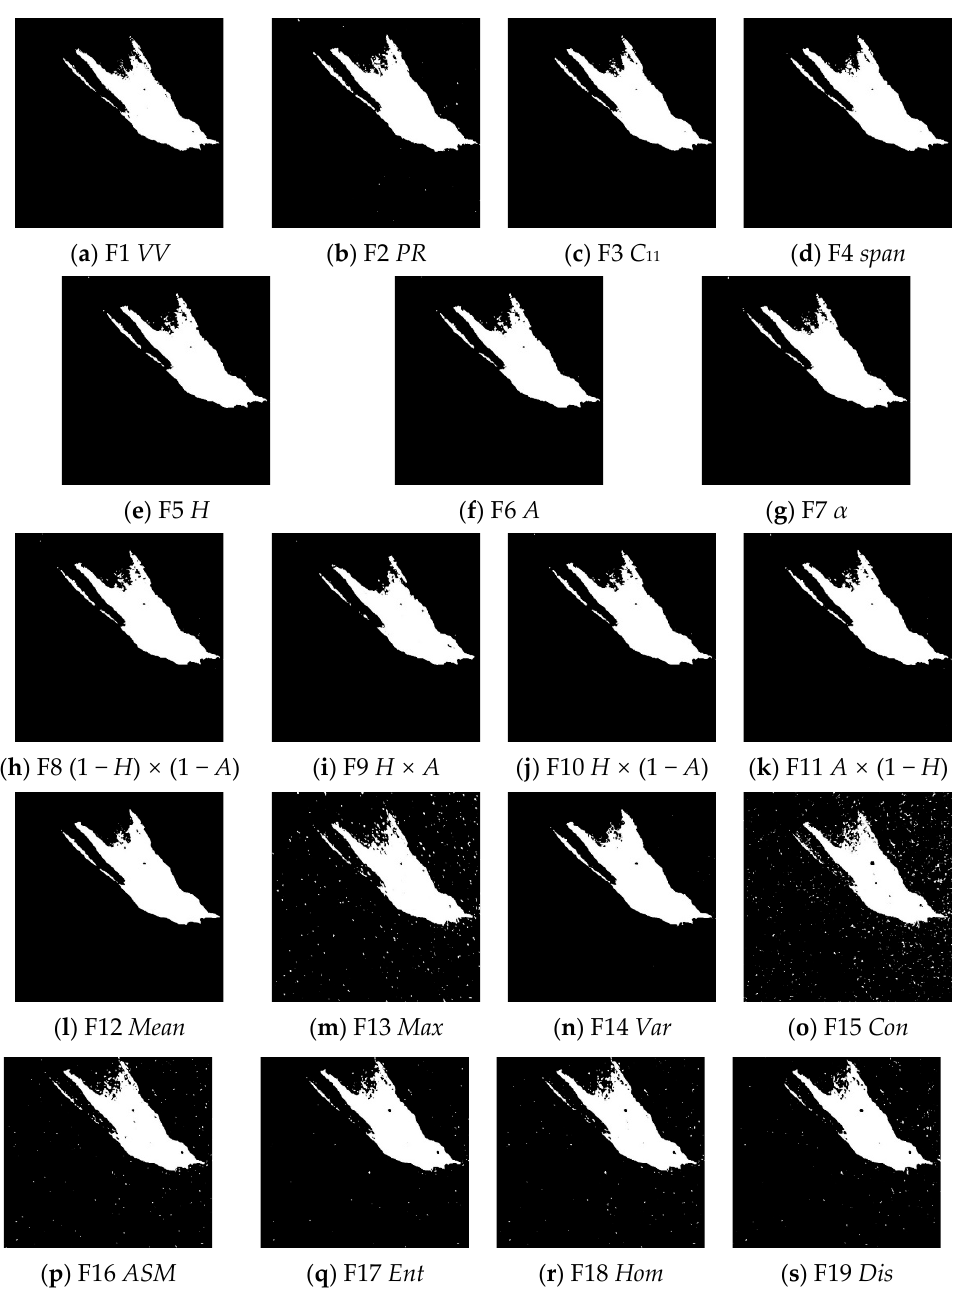
Figure 8. Image segmentation result for data a based on J–M/K-means algorithm.